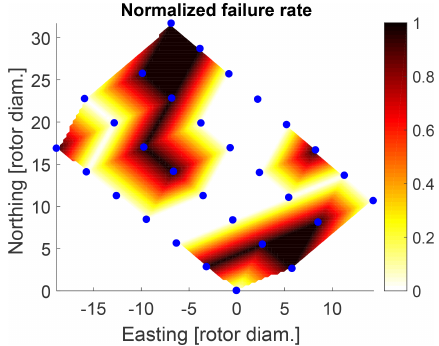
Figure 5. Observed normalized failure rate within wind farm from inspection reports.